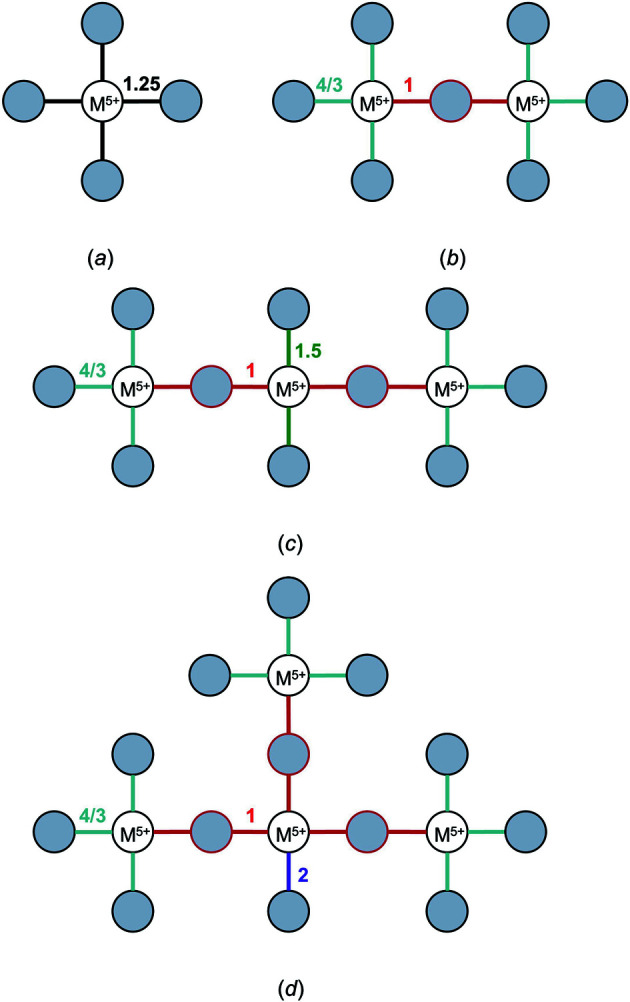
Bond-valence patterns arising from various corner-sharing tetrahedra for the +5 oxidation state for (a) monomers, (b) dimers, (c) linear oligomers and chains, and (d) branched polymers. Shaded spheres represent O2−.